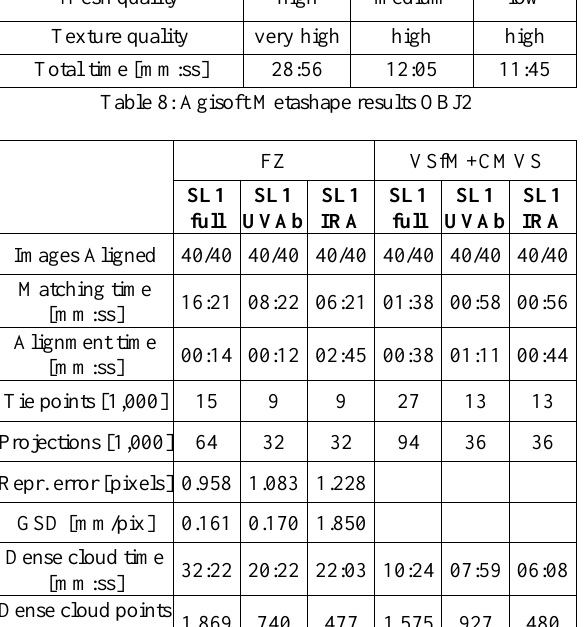
Table 9: 3DFlow Zephyr and VSfM+CMVS results OBJ2 For OBJ2, ZA and VSfM were able to only partially reconstruct